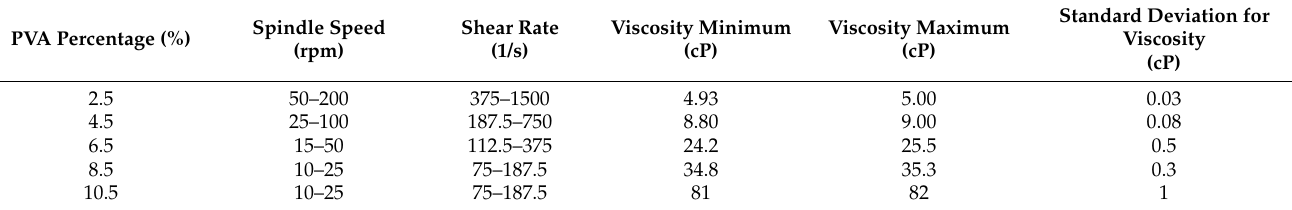
Table 1. Viscosity measurement of all five PVA solution.